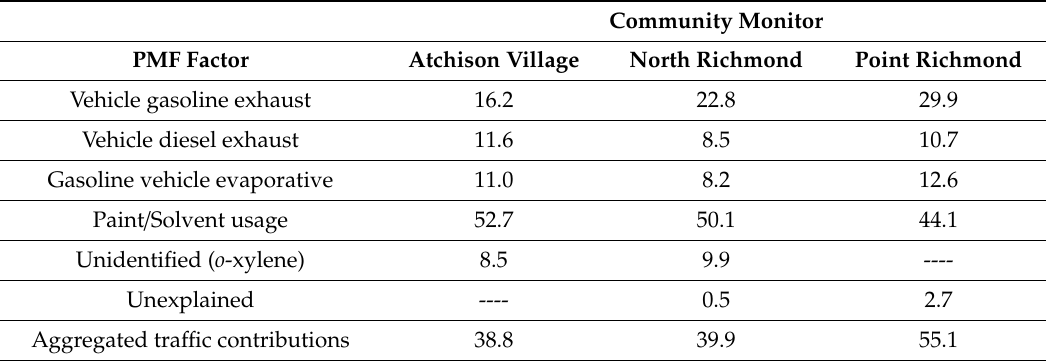
Table 3. Average contributions (%) of the PMF factors to the observed VOC concentrations at the three community